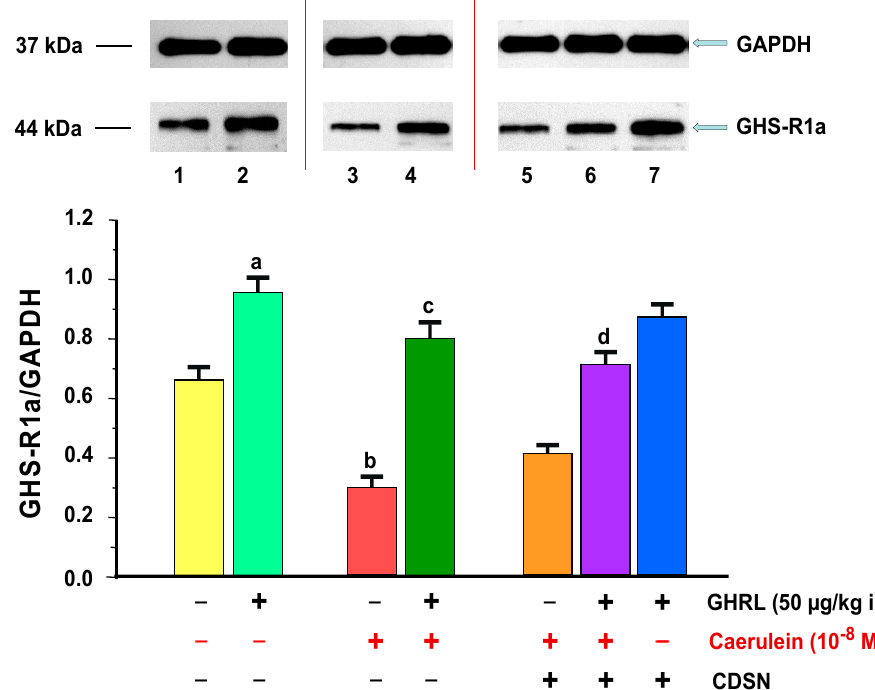
Figure 2. Analysis of the growth hormone secretagogue receptor 1a (GHS-R1a) protein production determined by the methods of immunoblotting and immunoprecipitation, and densitometric analysis of GHS-R1A/glyceraldehyde-3-phosphate dehydrogenase (GAPDH) protein ratio in pancreatic acinar cells: (line 1) acinar cells obtained from control sensory nerves (SN)-intact rats treated with saline, after isolation, acinar cells incubated in caerulein-free solution; (line 2) acinar cells obtained from SN-intact rats treated with ghrelin (GHRL), after isolation, acinar cells incubated in caerulein-free solution; (line 3) acinar cells obtained from SN-intact rats treated with saline, after isolation, acinar cells incubated in solution containing caerulein at a concentration of 10 − 8 M; (line 4) acinar cells obtained from SN-intact rats treated with GHRL, after isolation, acinar cells incubated in solution containing caerulein at a concentration of 10 − 8 M; (line 5) acinar cells obtained from rats with capsaicin deactivation of SN (CDSN) and treated with saline, after isolation, acinar cells incubated in solution containing caerulein at a concentration of 10 − 8 M; (line 6) acinar cells obtained from rats with CDSN and treated with GHRL, after isolation, acinar cells incubated in solution containing caerulein at a concentration of 10 − 8 M; (line 7) acinar cells obtained from rats with CDSN and treated with GHRL, after isolation, acinar cells incubated in caerulein-free solution. Reference protein: GAPDH. a,b p < 0.05 compared to control acinar cells obtained from rats with intact SN (line 1); c p < 0.05 compared to acinar cells stimulated with caerulein after isolation from SN-intact rats treated with saline (line 3); d p < 0.05 compared to acinar cells stimulated with caerulein after isolation from rats with CDSN and treated with saline (line 5). In each experimental group, the number of observations was at least 6.